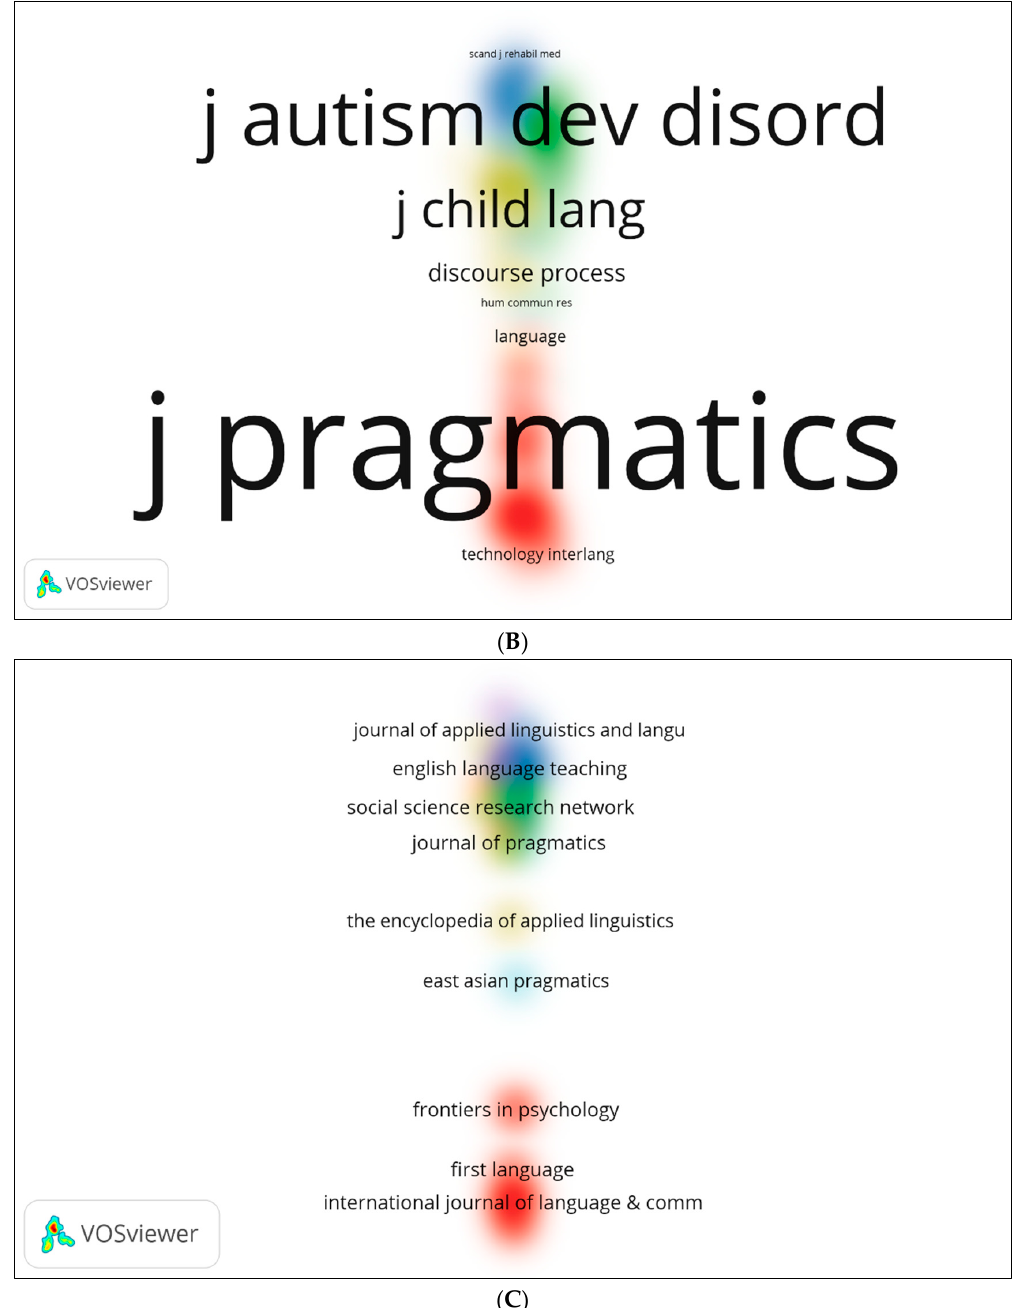
Figure 12. Density visualisation of (co)-citation by source: ( A ) Scopus; ( B ) WOS; ( C ) Lens—citation.